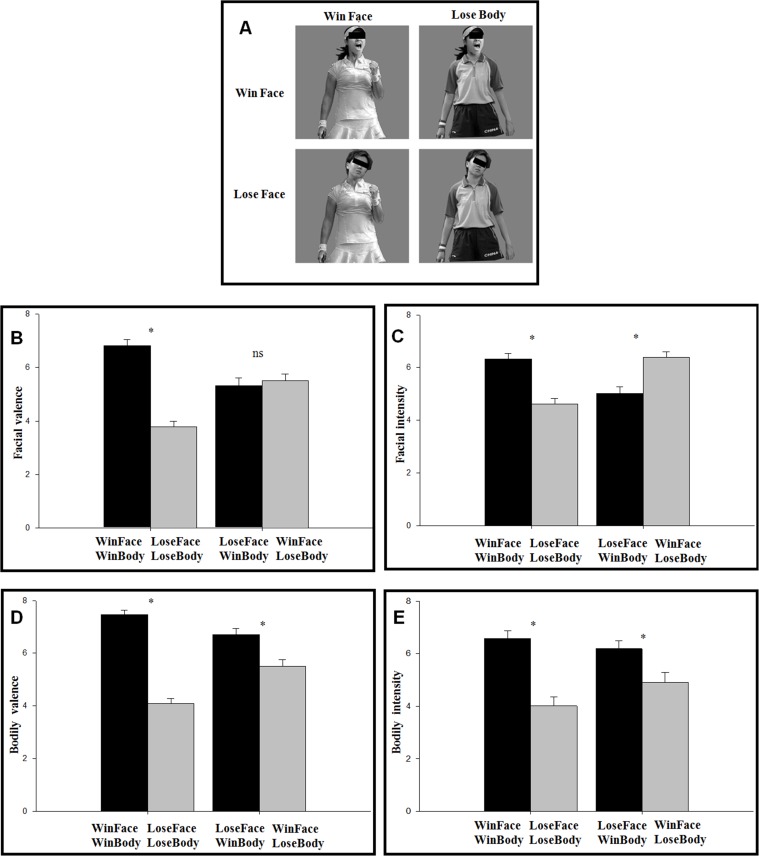
(A) Examples of experimental stimuli. (B) The valence of facial expressions (9-point scale, 1-the most negative, 9-the most positive). (C) The intensity of facial expressions (9-point scale, 1-the least intense, 9-the most intense). (D) The valence of body expressions. (E) The intensity of body expressions. Asterisk indicates significant difference (p < 0.05) while ns indicates no significance. Error bars show one standard error (S.E).